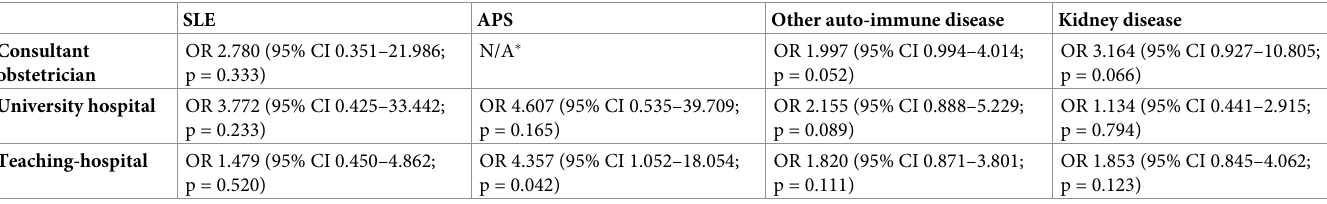
Table 3. Subgroup analyses of respondents characteristics to tertiary care aspirin indications in 2021. SLE APS Other auto-immune disease Kidney